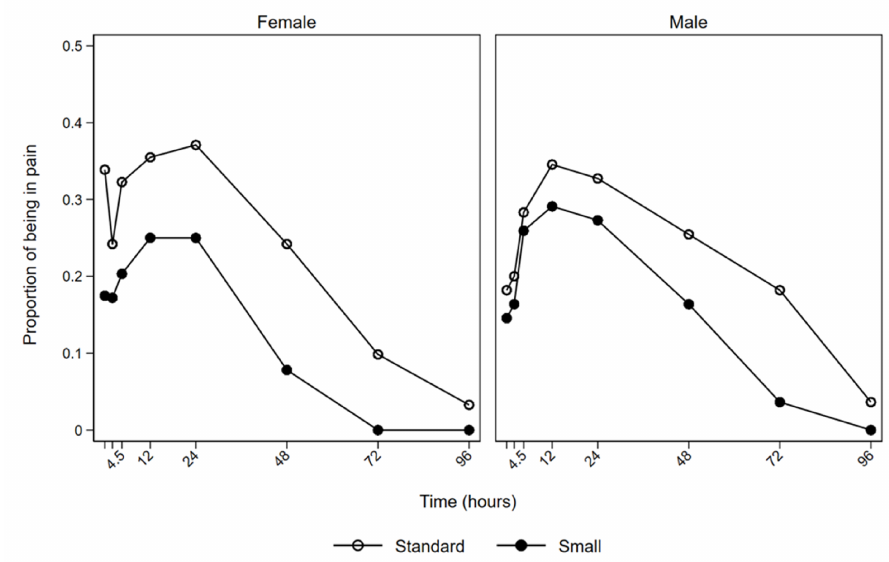
Figure 3. Proportion of patients experiencing pain over time.